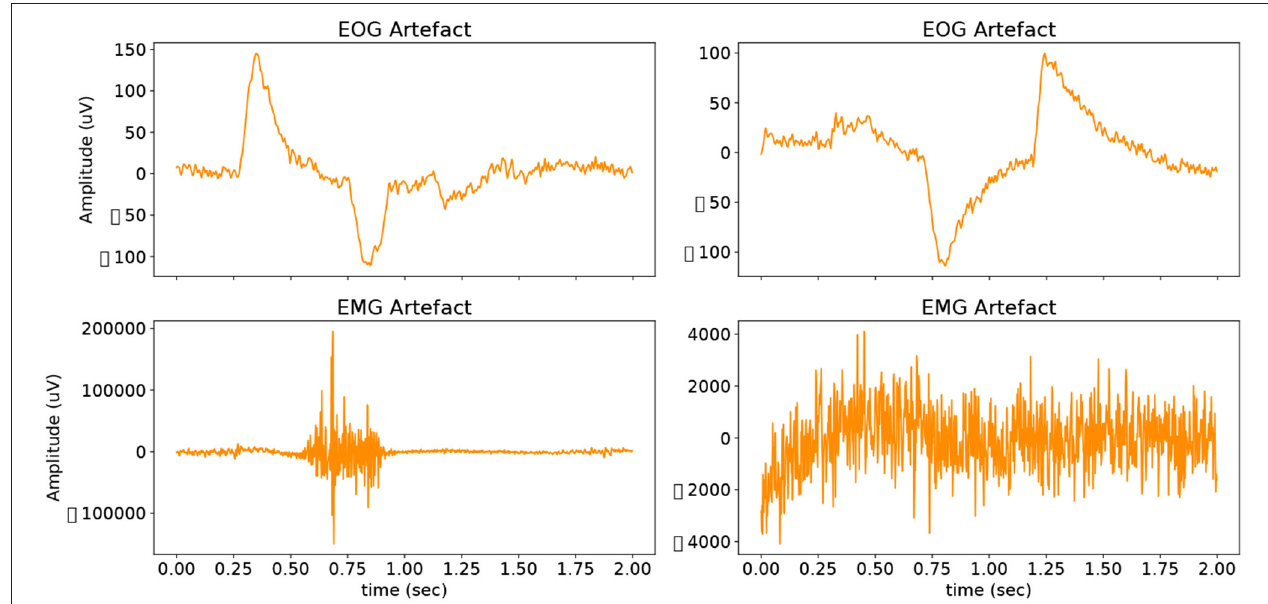
FIGURE 3 | Examples of both EOG and EMG artefacts that have been artificially added to the